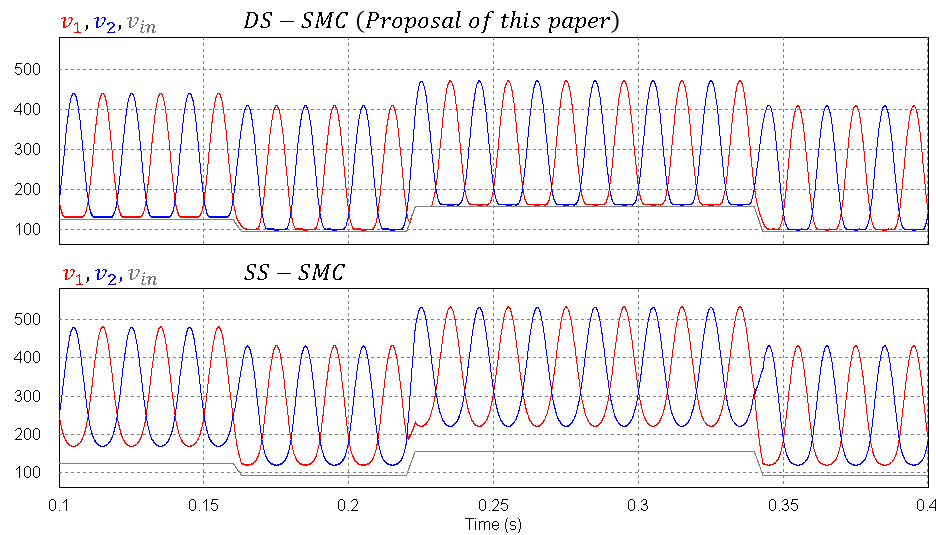
Figure 13. Simulated semiconductor voltages comparing SS-SMC and DS-SMC for simulation test 2. Figure 14. Simulated semiconductor voltages comparing SS-SMC and DS-SMC for simulation test 2. Table 7. Comparison of control methods regarding semiconductor voltage